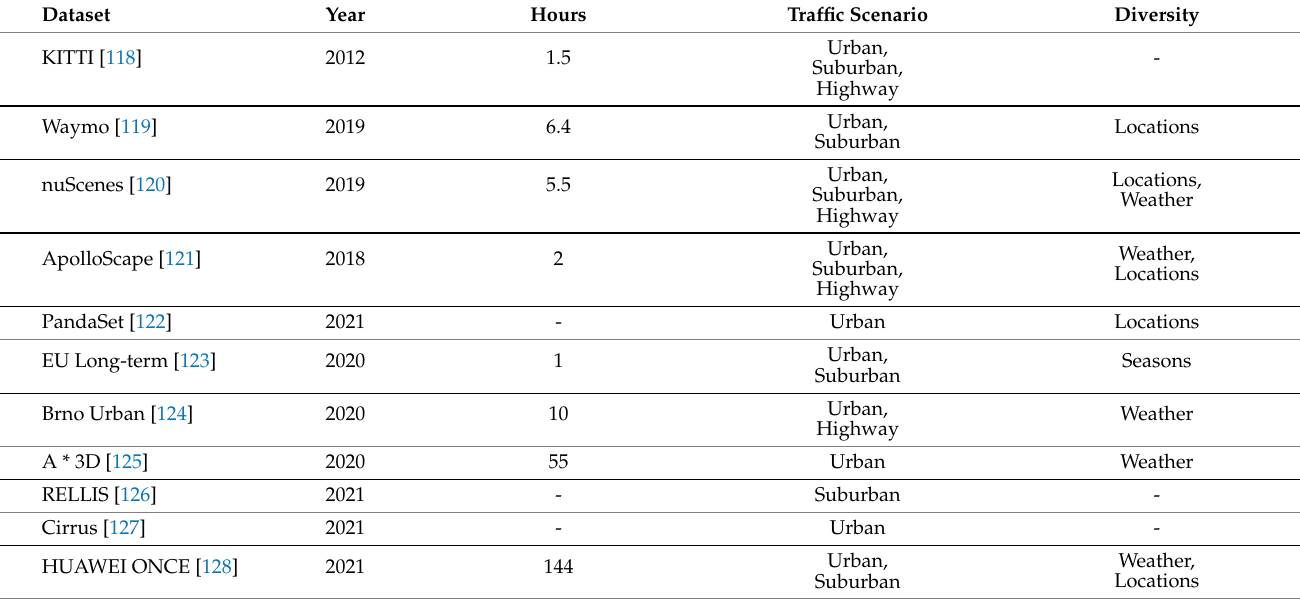
Table 4. Frequently used datasets for AVs.